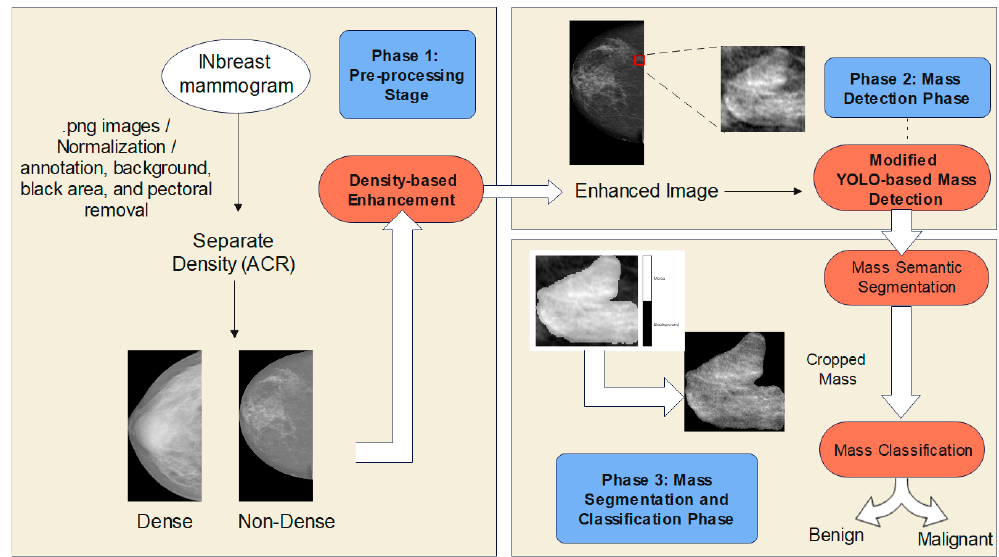
Figure 2. Overall Proposed Methodology for Breast Mammogram Mass Classification.